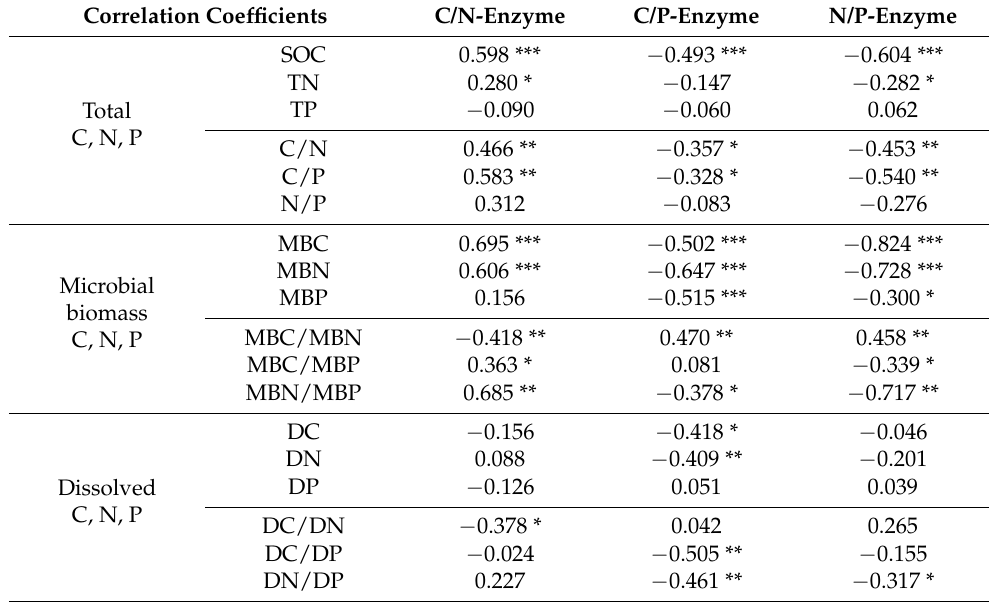
Table 2. Pearson correlation coefficients between soil C, N and P fractions variables and soil extracel- lular enzymatic